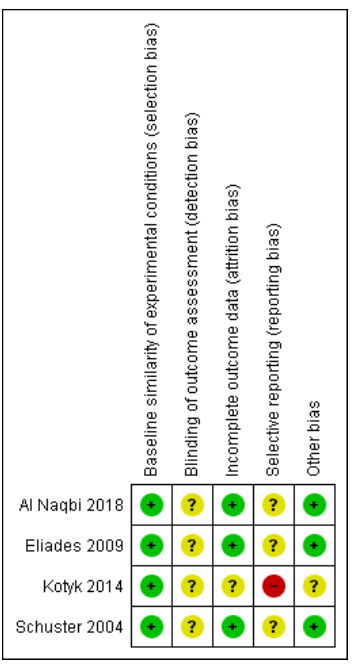
Table 2. Risk of bias of included randomized clinical trial with the RoB 2.0 tool.